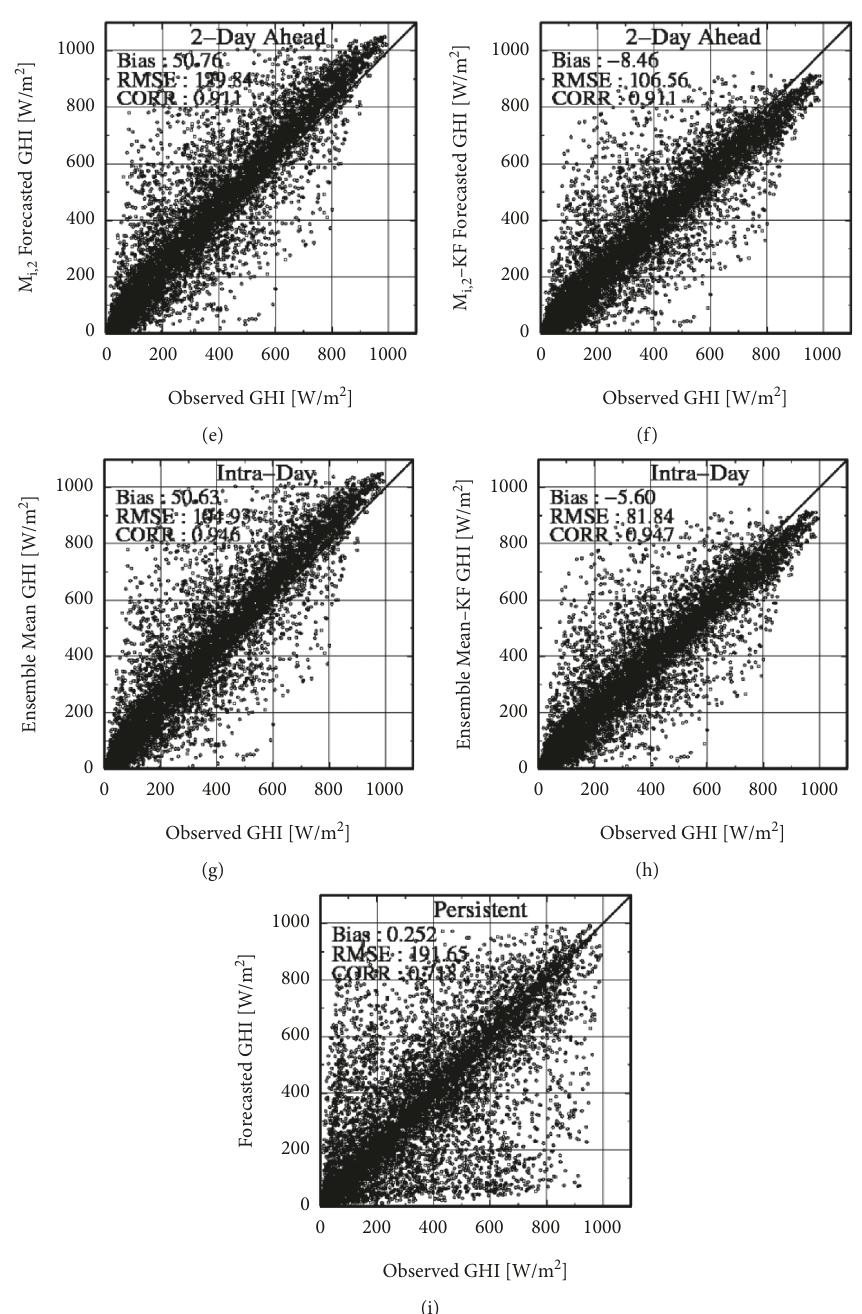
Figure 5: Correlation diagrams of the observed GHI and the forecasted data for the intraday prediction, next-day prediction, 2-day ahead prediction, and ensemble mean with the meteorological model WRF only ( M i, treatment Kalman filter ( M i, M − KF prediction, (c) M i, 0 ensemble mean − KF, and (i)